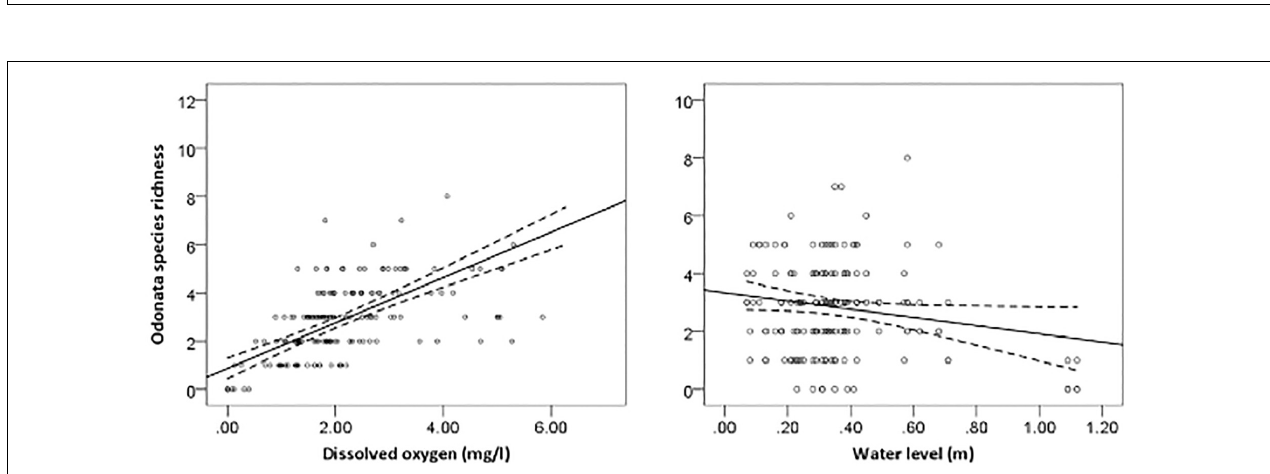
Frontiers in Forests and Global Change |